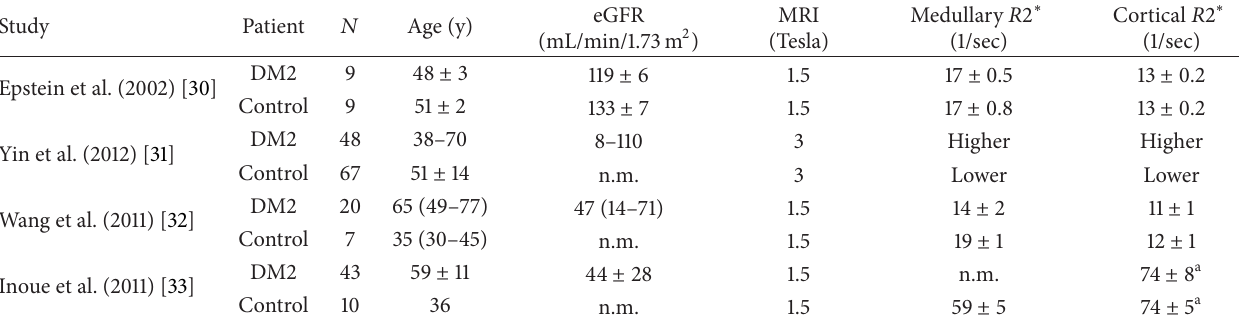
Table 1: Case control studies that have assessed renal oxygenation in